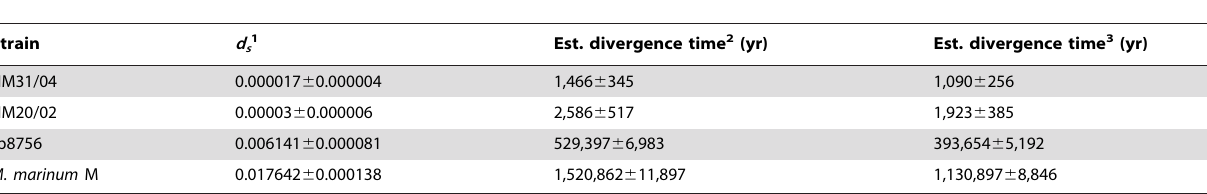
Table 4. Estimation of time of divergence between M. ulcerans Agy99 and other M. ulcerans and M. marinum strains.